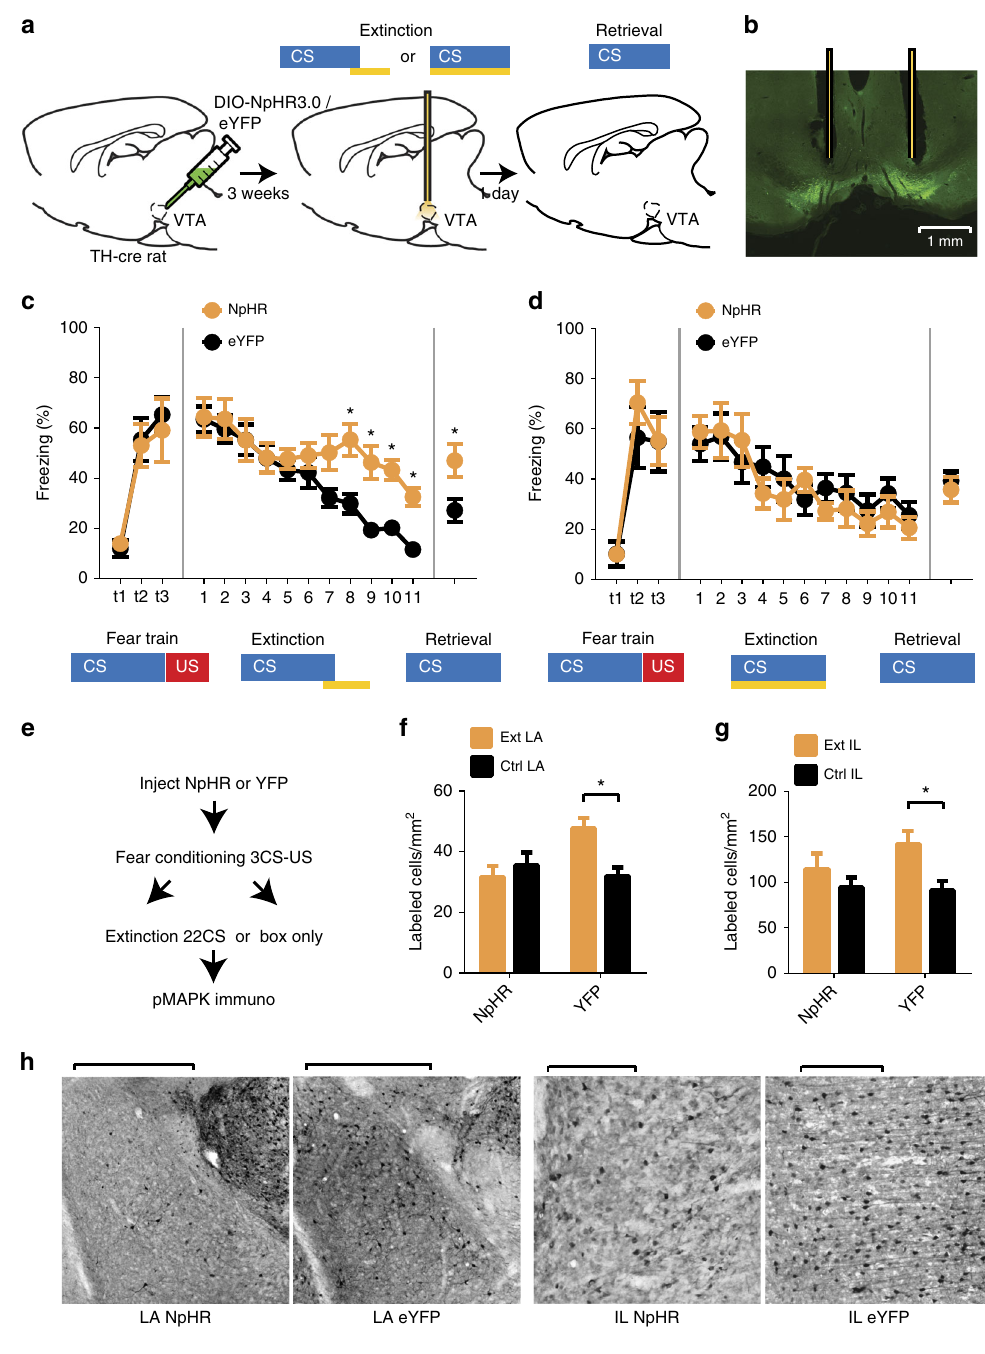
Fig. 1 Optogenetic inhibition of VTA-dopamine neurons during shock omission blocks extinction learning. a Experimental paradigm for optogenetic inactivation of VTA-dopamine neurons during expected shock omission or auditory CS presentation of fear extinction. Brain image adapted from ref. 70 . Copyright 1982, Elsevier. b Expression of NpHR3.0-eYFP in VTA (scale bar = 1mm). c Inactivation of VTA-dopamine cells during shock omission period reduced “ extinction ” learning ( n = 7 NpHR, 10 YFP, 2-trial average, F 10, 150 = 4.709, p <0.0001 signi fi cant interaction, 2-way repeated measures ANOVA, * p = 0.0090, 0.0050, 0.0229, 0.0466 for trials 8, 9, 10, 11, simple effects of inactivation, Holm – Sidak multiple comparison) and extinction memory consolidation measured during a “ retrieval ” test (5-trial average, * p = 0.0212, Student ’ s t -test). d Inactivation of VTA-dopamine cells during CS tone presentation affected neither extinction learning ( n = 6 NpHR, 6 YFP, 2-trial average, F 10, 100 = 0.903, p = 0.5339 no interaction, 2-way repeated measures ANOVA) nor consolidation (5-trial average, p = 0.5874, Student ’ s t -test). e Paradigm for assessing MAPK phosphorylation (pMAPK) in lateral amygdala (LA) and infralimbic (IL) cortex following optogenetic inhibition of VTA-dopamine cells during shock omission period of extinction. f , g Inhibition of VTA-dopamine neurons during shock omission period of extinction abolished the increase in pMAPK following extinction found in non-inhibited animals (LA: n = 8 NpHR, 10 YFP, 4-slice average, F 1, 32 = 7.153, p = 0.0117 signi fi cant interaction, p = 0.0333 main effect of inactivation in extinction, * p = 0.0287 simple effect of extinction in YFP; IL: n = 8 NpHR, 10 YFP, F 1, = 1.343, p = 0.255 no interaction, F = 7.334, * p = 0.011 simple effect of extinction in YFP; 2-way ANOVA). h Representative examples (left LA, scale bars 32 1, 32 = 1mm, right IL, scale bars = 0.2mm) of pMAPK positive cells in extinction groups in NpHR3.0-eYFP and eYFP treated animals. Error bars indicate